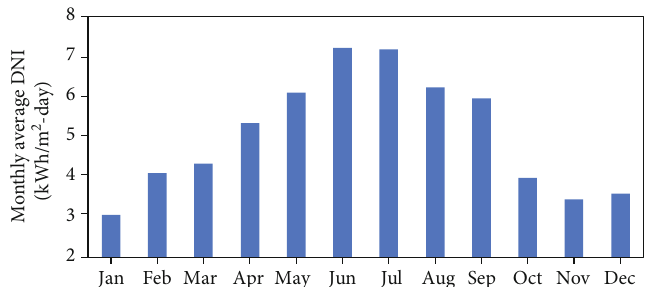
Figure 2: Monthly average global daily solar radiation on a horizontal surface.